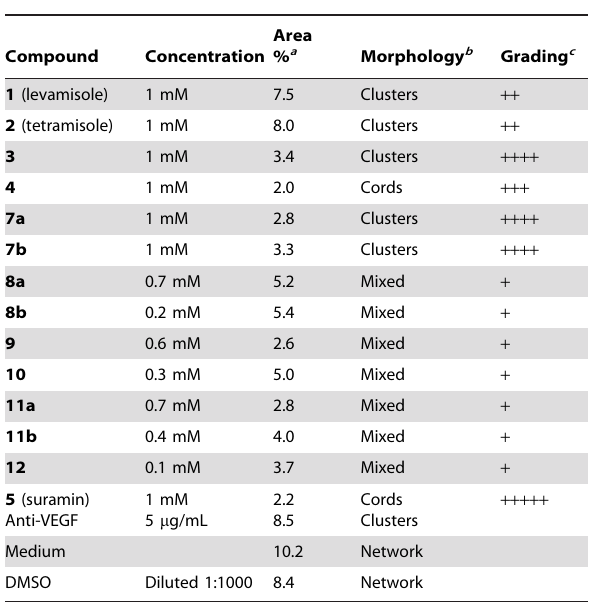
Table 1. Results of in vitro angiogenesis inhibition of levamisole and its derivatives in comparison with suramin (5), vehicle (DMSO), and medium alone, as observed by HUVEC number and morphology.